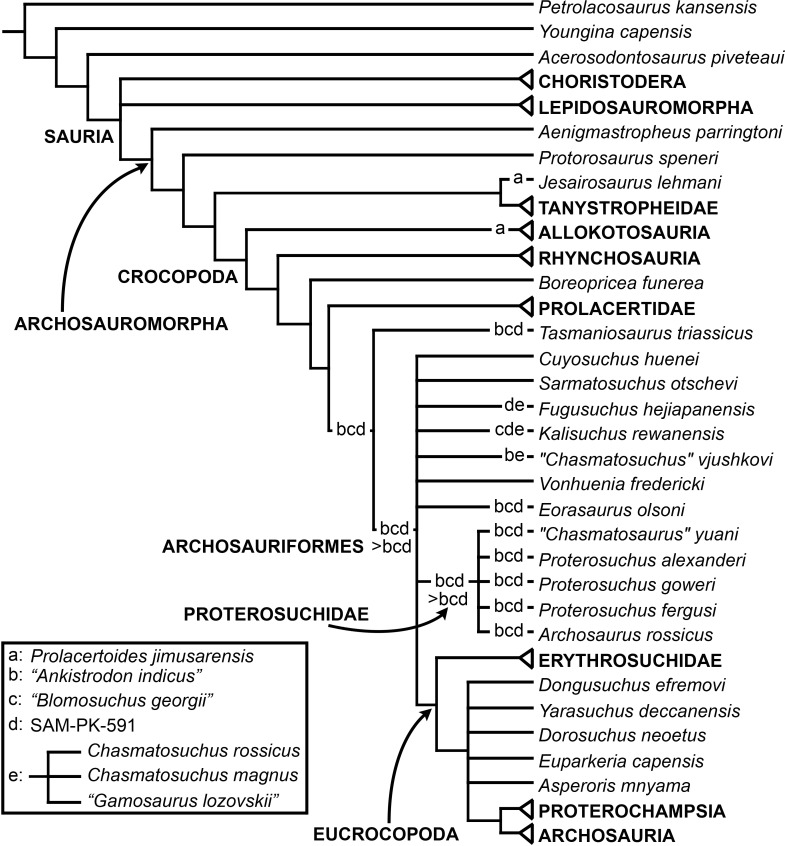
First strict reduced consensus tree recovered from analyses 1 indicating the alternatives positions that Prolacertoides jimusarensis, “Ankistrodon indicus,” “Blomosuchus georgii,” SAM-PK-591 and the genus Chasmatosuchus adopt in the most parsimonious trees.Some clades have been condensed into suprageneric terminals to simplify the figure and their internal relationships are the same as in Figs. 47–51.